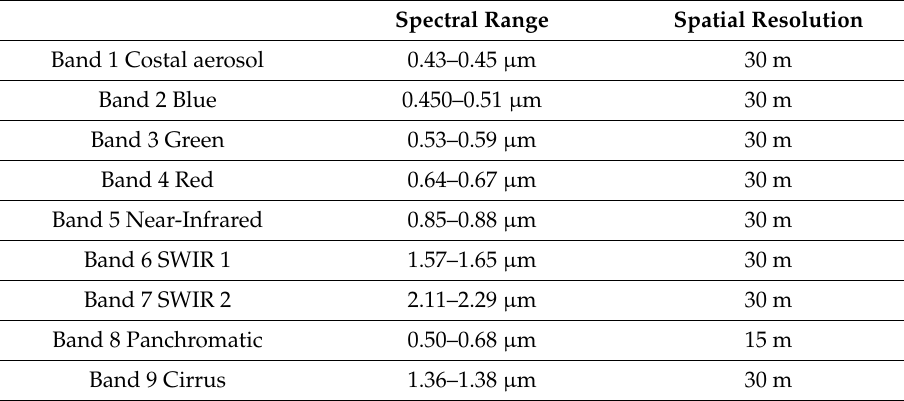
Table 1. Summary of the OLI bands from Landsat